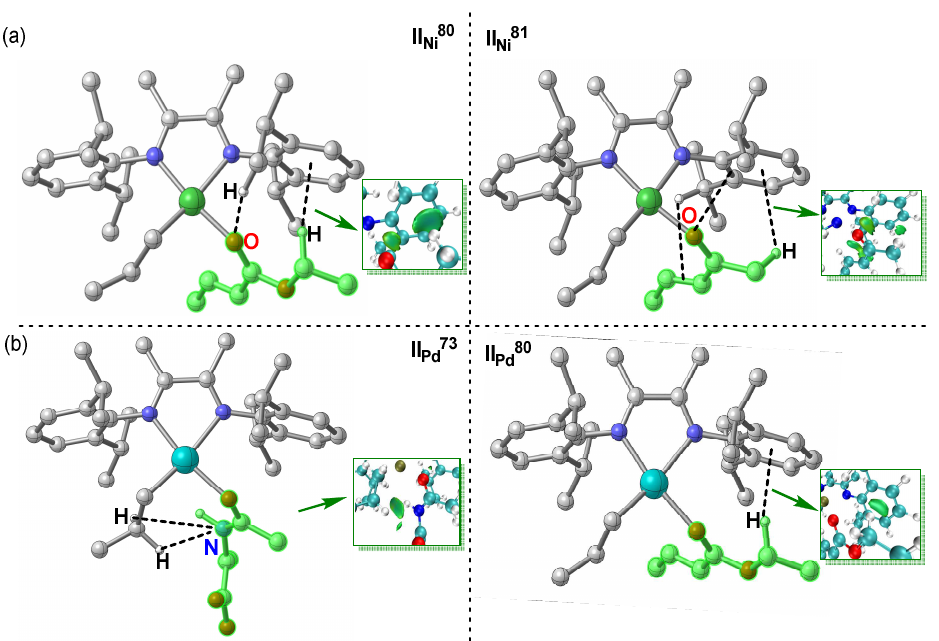
Figure 6. Structure and non-covalent interaction of deviation points in complexes II Ni ( a ) and II Pd ( b ) systems.